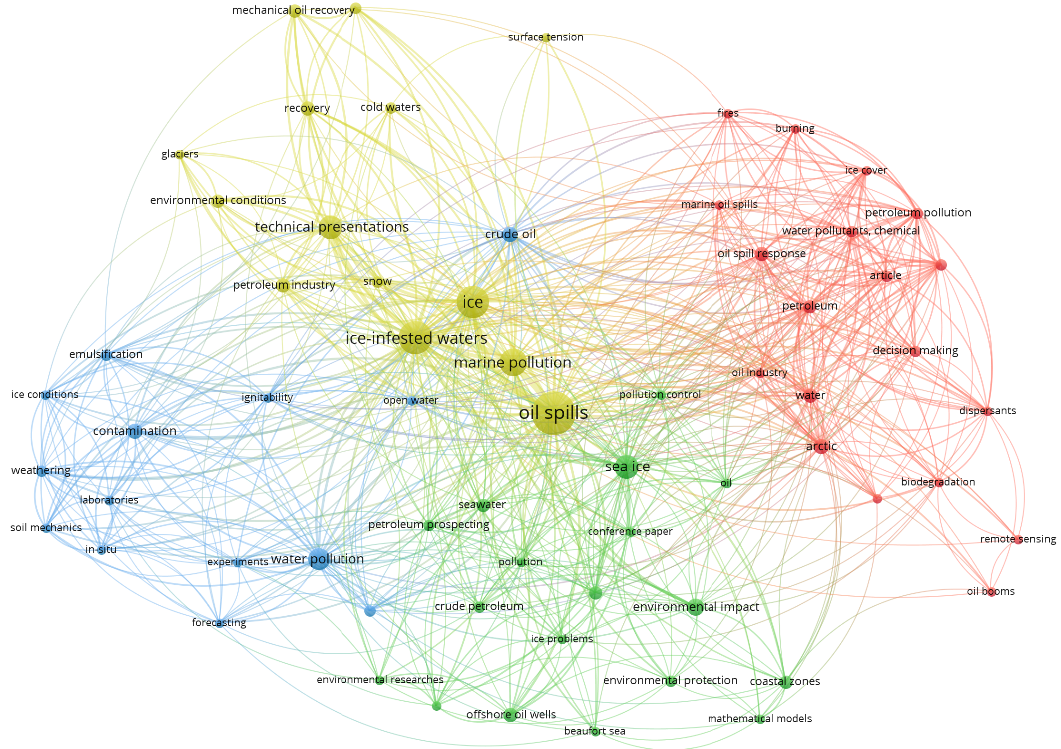
Figure 6. Analysis of terms in oil spills publications in ice ‐ infested waters.